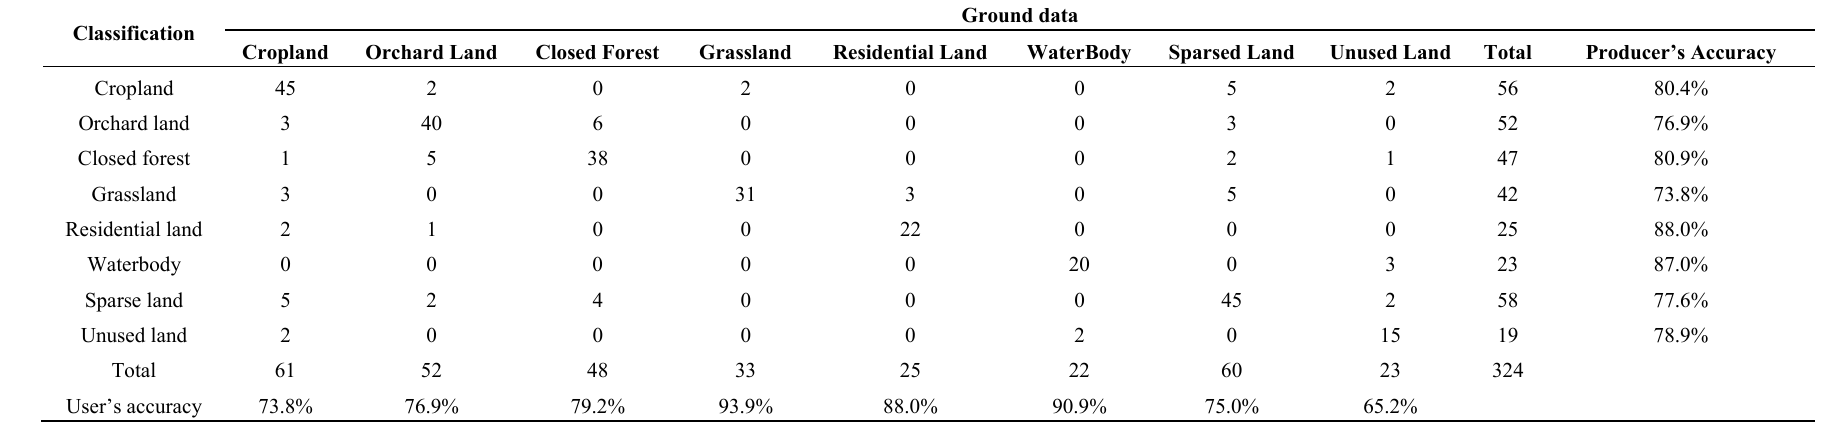
Table 3. Confusion matrix of the 2011 classified image of Yanchuan County.